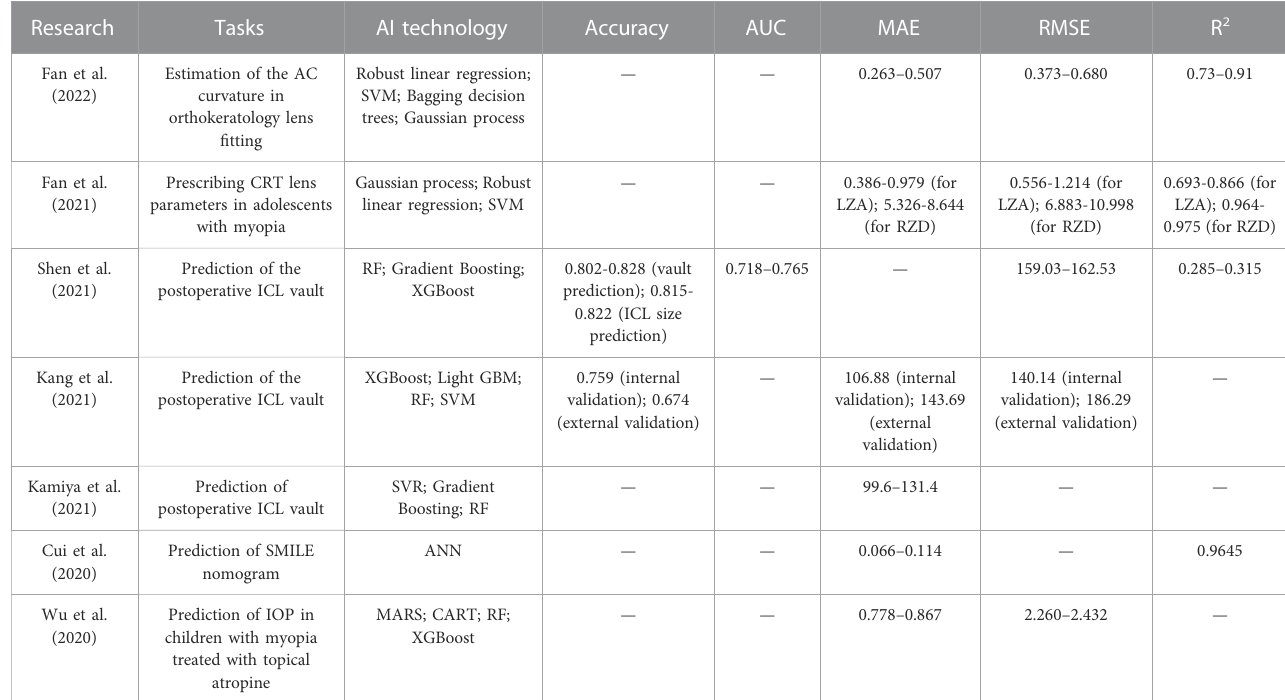
TABLE 4 Summary of AI technology for myopia treatment.